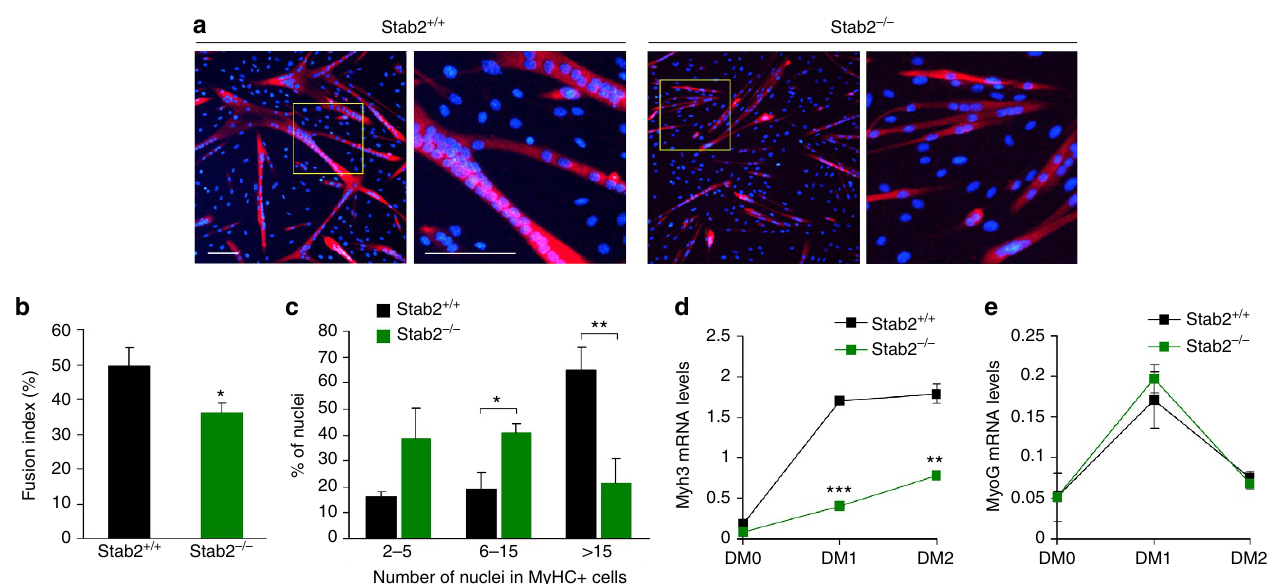
Figure 5 | Myoblast fusion is impaired in Stab2-deficient myoblasts. ( a ) Myoblasts isolated from Stab2 þ / þ and Stab2 (cid:2) / (cid:2) mice were plated at equal densities and induced to differentiate. After 48h, cells were fixed and immunostained with anti-MyHC antibody. Representative microscopic fields are presented. Yellow boxes are shown at higher magnification. Scale bar, 100 m m. ( b ) After 2 days of differentiation (DM2), fusion indices were determined for Stab2 þ / þ and Stab2 (cid:2) / (cid:2) myoblasts. Data are presented as mean ± s.d. of at least three independent experiments. ( c ) Stab2 þ / þ and Stab2 (cid:2) / (cid:2) myoblasts were fixed and immunostained for anti-MyHC antibody at DM2, and then the percentage of nuclei present in MyHC-positive cells with the indicated number of nuclei were calculated. Data are presented as mean ± s.d. of at least three independent experiments. ( d , e ) Stab2 þ / þ and Stab2 (cid:2) / (cid:2) myoblasts were induced to differentiate for the indicated times. The levels of embryonic MyHC ( Myf3 , d ) and myogenin ( MyoG , e ) mRNA were analysed by quantitative real-time PCR. Data are presented as mean ± s.d. of three independent experiments. Asterisks indicate statistical significance (* P o